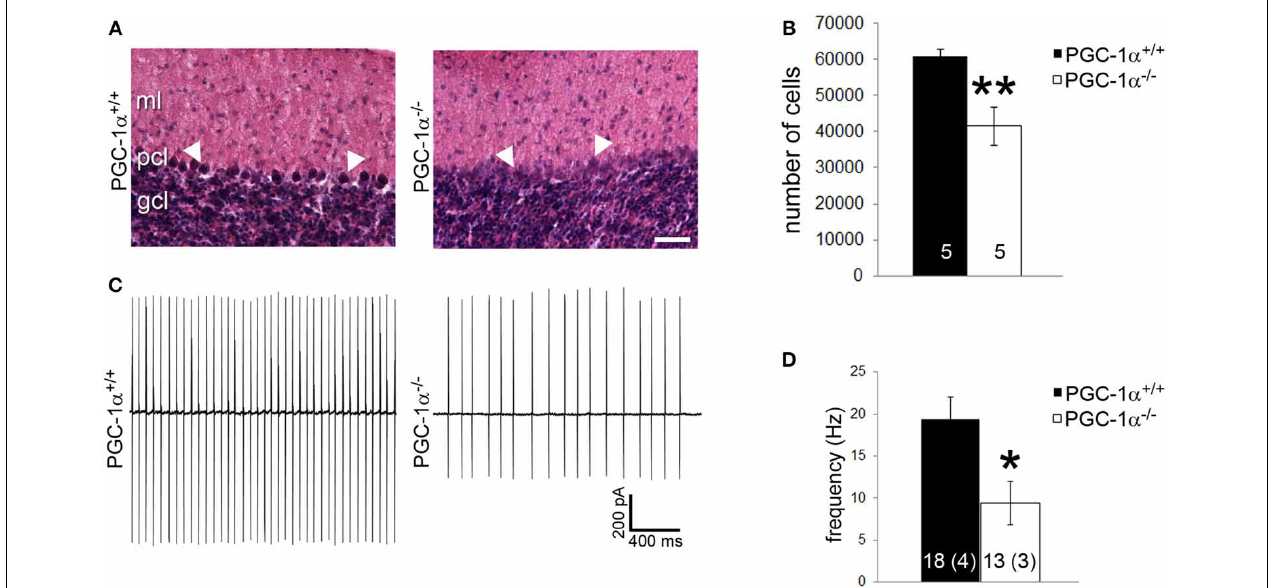
granule cell layer. ML, molecular layer. Scale bar = 100 μ m. (C) Loose patch electrophysiology was conducted in acute cerebellar slices to determine if loss of PGC-1 α leads to Purkinje cell dysfunction. (D) Purkinje cell spike rate was significantly reduced in PGC-1 α − / − compared to + / +